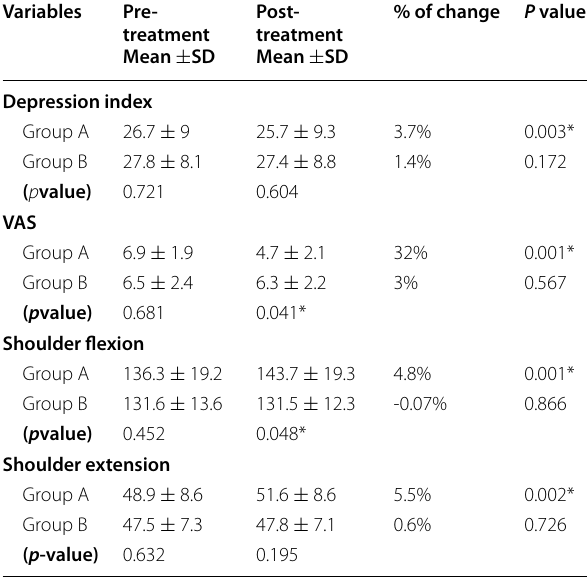
Table 3 Comparison between pre- and post-treatment mean values of measured variables between and within groups